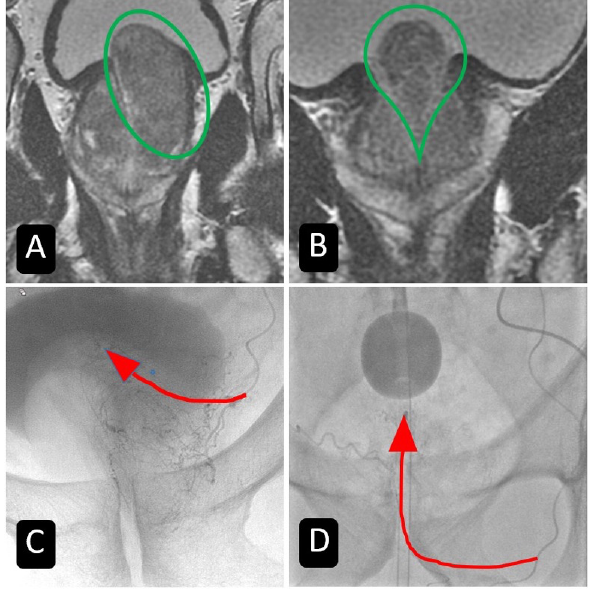
Fig. 1. Intravesical prostatic protrusion (IPP) caused by the lateral lobes of the prostate or by the middle lobe. (A) T2- weighted MRI of the prostate, with coronal angulation. The IPP relocates the urinary bladder outlet. The MRI clearly shows that the IPP is formed by the left lateral lobe in this case (outlined in green). (B) T2-weighted MRI of the prostate, coronal angulation. The urinary bladder outlet is also displaced by the IPP. The MRI clearly shows that the IPP is formed by the middle lobe in this case (outlined in green). (C) Angiography image of the prostate in the context of PAE. If the IPP is formed by the lateral lobe, the IPP is also supplied by the lateral lobe artery (red arrow). (D) Angiography image of the prostate in the context of PAE. If the IPP is formed by the middle lobe, the IPP is supplied by its own artery, which usually runs along the prostatic urethra from the apex to the base (red arrow).